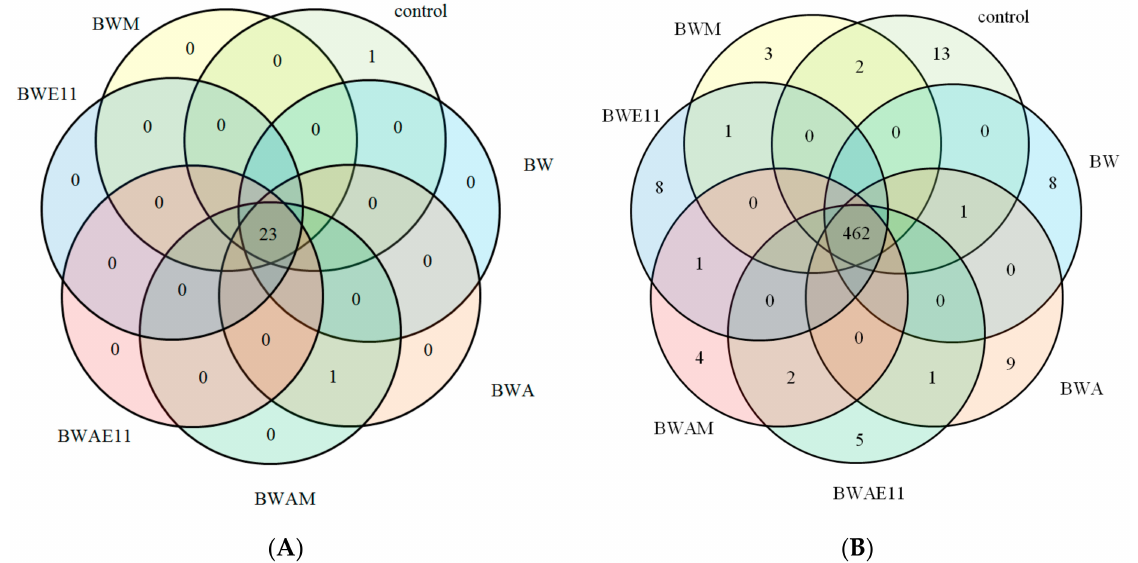
Figure 2. A Venn diagram of overlapping bacterial communities from the variants (( A )—phylum, ( B )—genus) Explanation: control ‘0’—without fertilisers and plant cultivation, control—the control variant without fertilisers, with plant cultivation, BW—biochar fertiliser, BWM—biochar fertiliser with mycorrhizal fungi, BWE11—biochar fertiliser with Bacillus bacteria, BWA—biochar fertiliser with algae, BWAE11—biochar fertiliser with algae and Bacillus sp. bacteria, BWAM—biochar fertiliser with algae and mycorrhizal fungi.